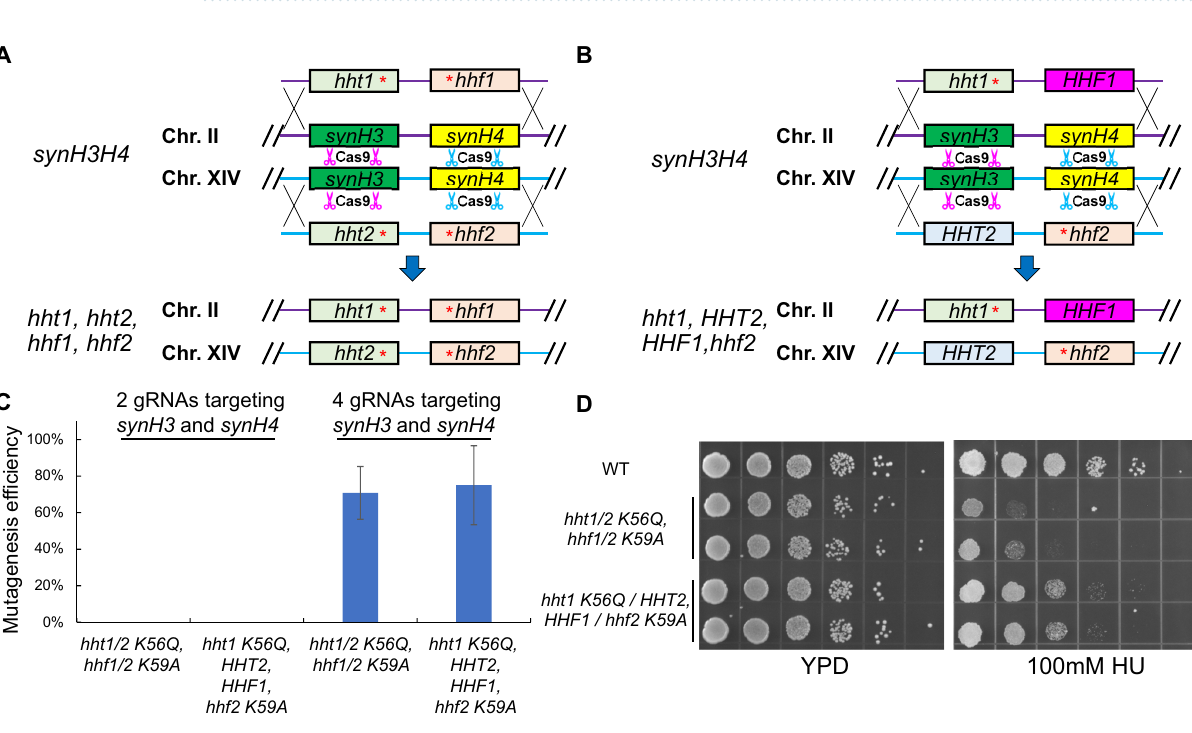
Figure 5. Mutagenesis on both histone H3 and H4 through single transformation. ( A , B ) Graphic representation of CRISPR-Cas9 based gene replacement for mutagenesis on both histone H3 and H4 with different combinations. By transforming different donors, the endogenous two copies of histone H3 and H4 can be repaired for identical mutants ( A ) or with different mutation sites ( B ). ( C ) The mutagenesis efficiencies for generating histone H3 and H4 mutants through single transformation with different gRNAs. 2 gRNAs: 1 gRNA targeting synH3 and 1 gRNA targeting synH4 and 4 gRNAs: 2 gRNAs for each synthetic histone. The data of bar charts represent mean averages of over-all mutagenesis efficiencies of 3 biological replicates with each randomly picked 8 colonies. The error bars indicate the standard deviations of 3 biological replicates. ( D ) Confirmation of HU sensitivity of histone H3 and H4 mutant. Two biological replicates were grown in YPD overnight at 30 °C. Serial tenfold dilutions were spotted onto YPD or YPD with 100 mM HU and incubated at 30 °C for 3